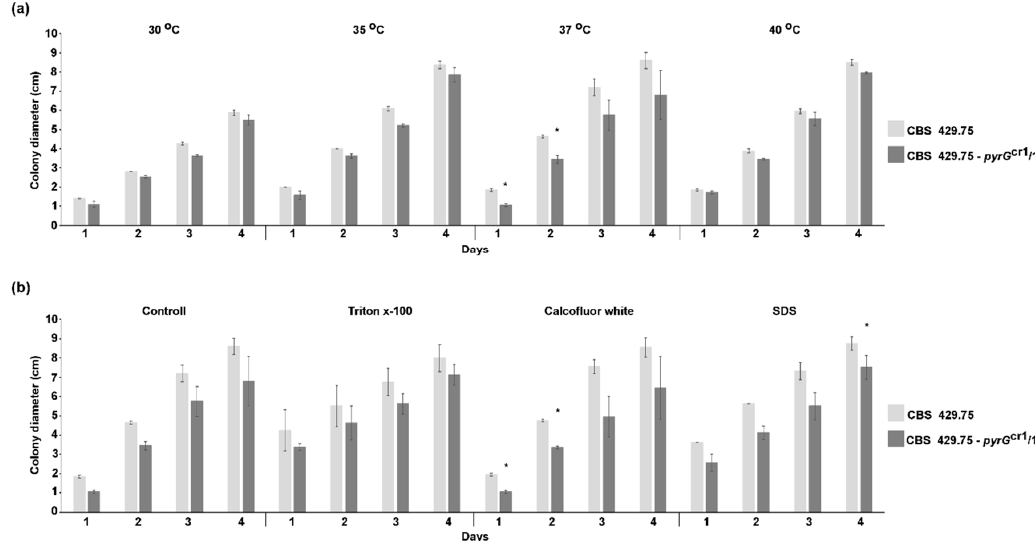
Figure 5. Growth of the original L. corymbifera strain (CBS 429.75) and one of the mutants (CBS 429.75– pyrG cr1 /1) at different temperatures ( a ) and in the presence of different stressors ( b ). The presented values are averages; colony diameters were measured during three independent cultivation (error bars indicate standard deviation). Asterisk (*) indicates significant difference from the corresponding value of the CBS 429.75 strain according to the paired t -test ( p < 0.05). Susceptibility of the pyrG disruption mutants and the original strain to oxidative stress was also examined. Strains, in which the pyrG gene was disrupted, showed a tendency to slightly higher sensitivity to hydrogen peroxide (H 2 O 2 ) than the parental strain, but this difference was not found to be significant (Figure 6a).